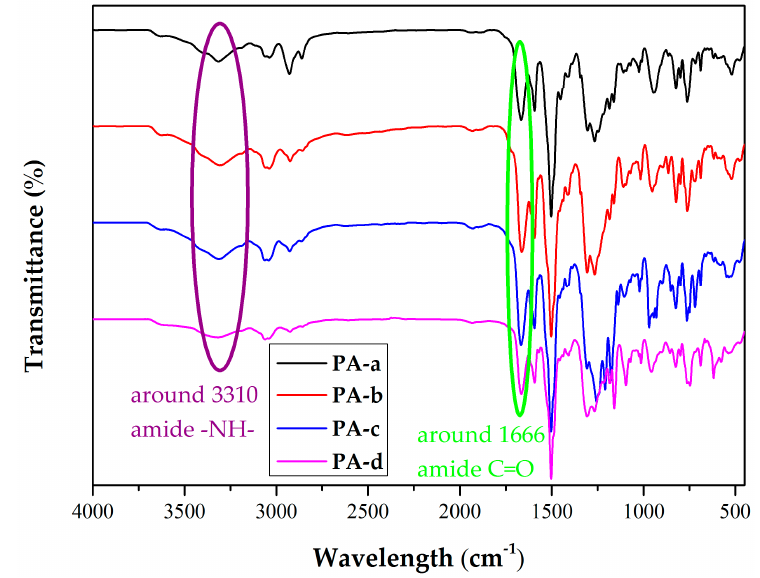
Figure A9. IR of PAs.